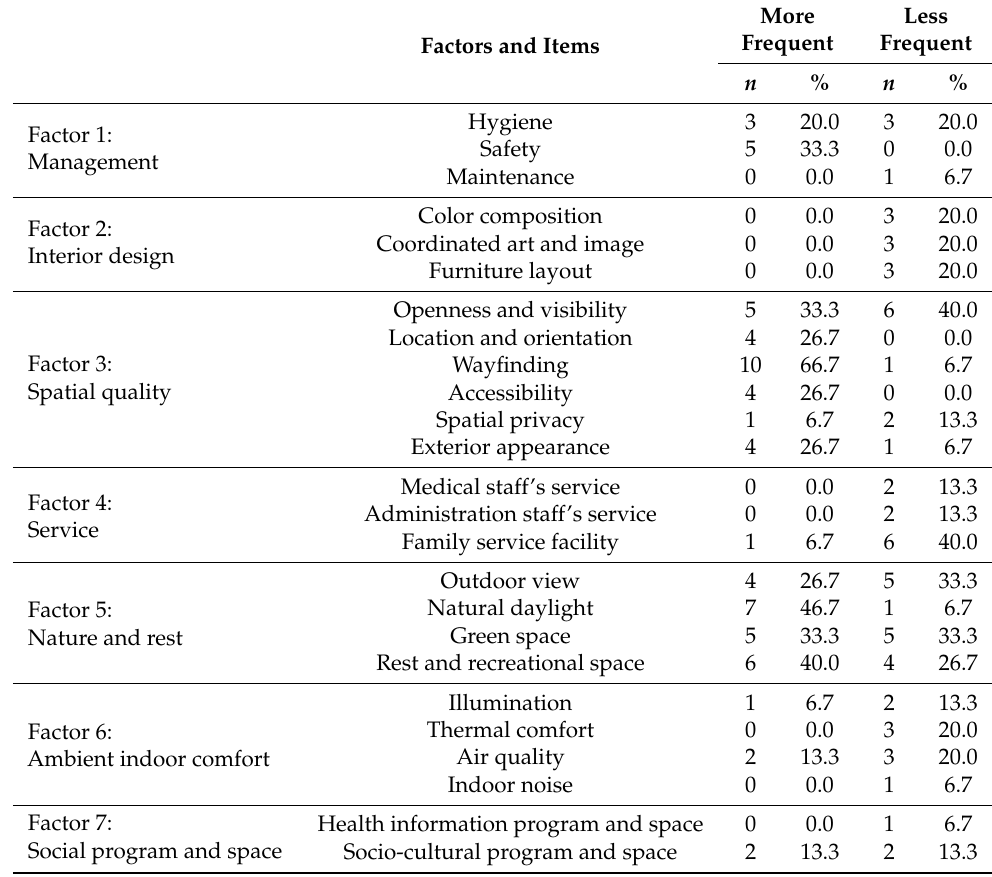
Table A2. Frequency of applied variables in design implementation for therapeutic hospital